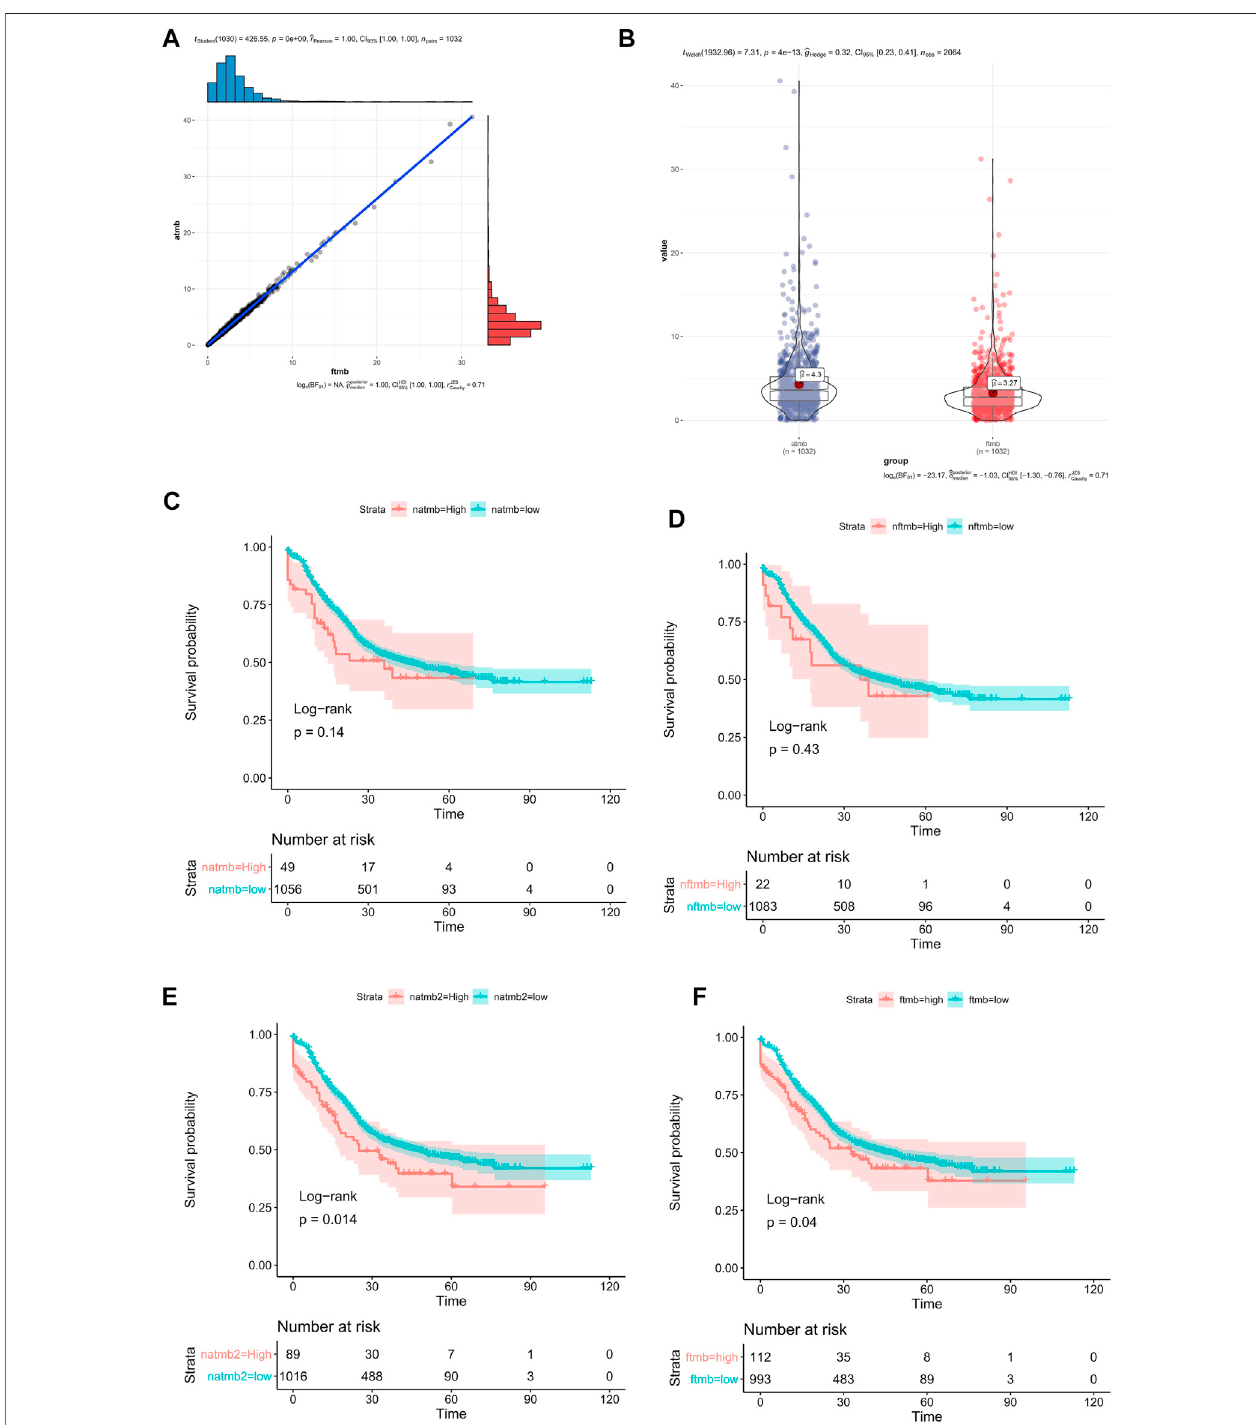
FIGURE 3 | TMB in ESCC. (A) the correlation between aTMB and fTMB, (B) compared the mean value between aTMB and fTMB, (C) Survival analysis of aTMB (high aTMB > 10), (D) Survival analysis of fTMB (high fTMB > 10), (E) Survival analysis of aTMB (high aTMB > 8.0), (F) Survival analysis of fTMB (high fTMB > 5.7).